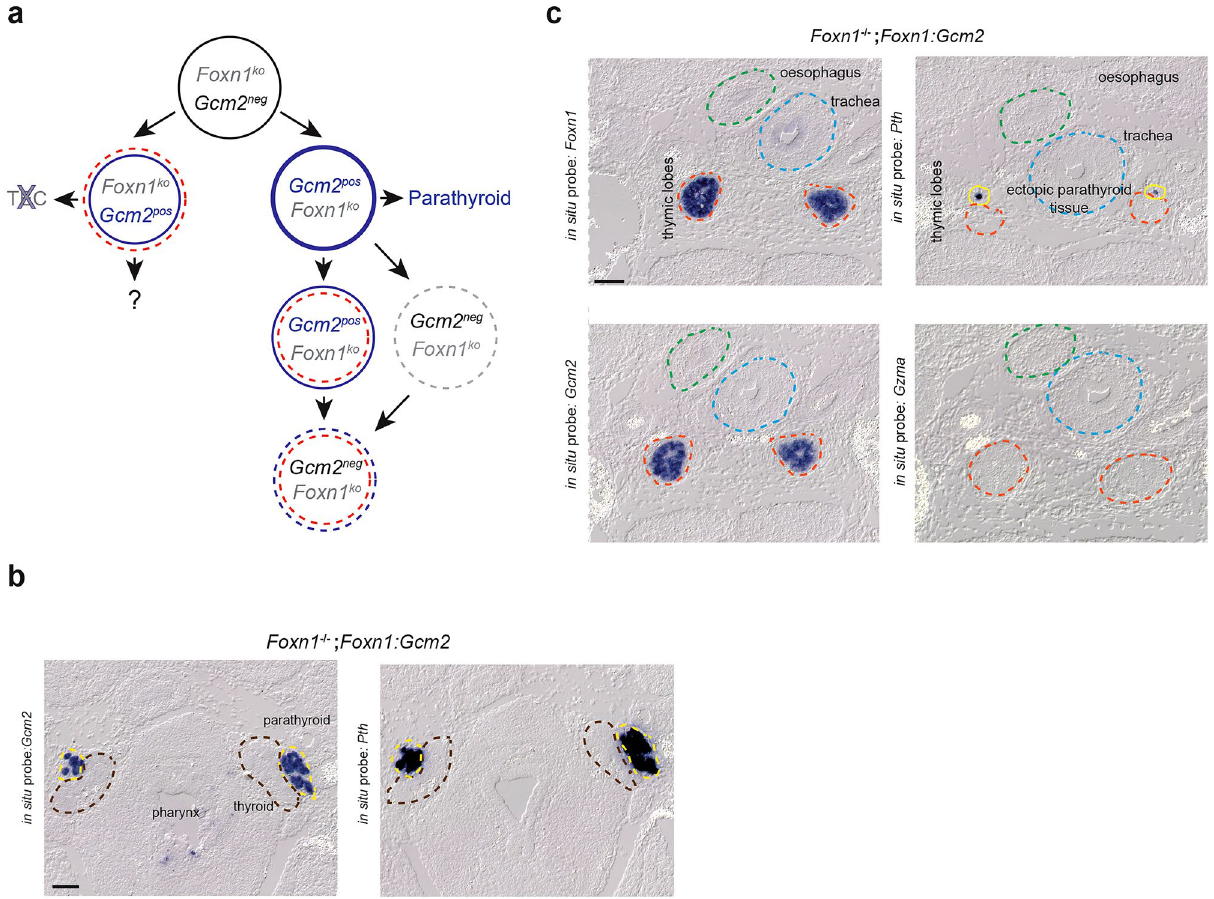
Figure 3. Ectopic expression of Gcm2 in the thymic epithelium of Foxn1 -deficient mice. ( a ) Developmental trajectories under conditions of ectopic Gcm2 expression in Foxn1 -negative thymic epithelial cells; note